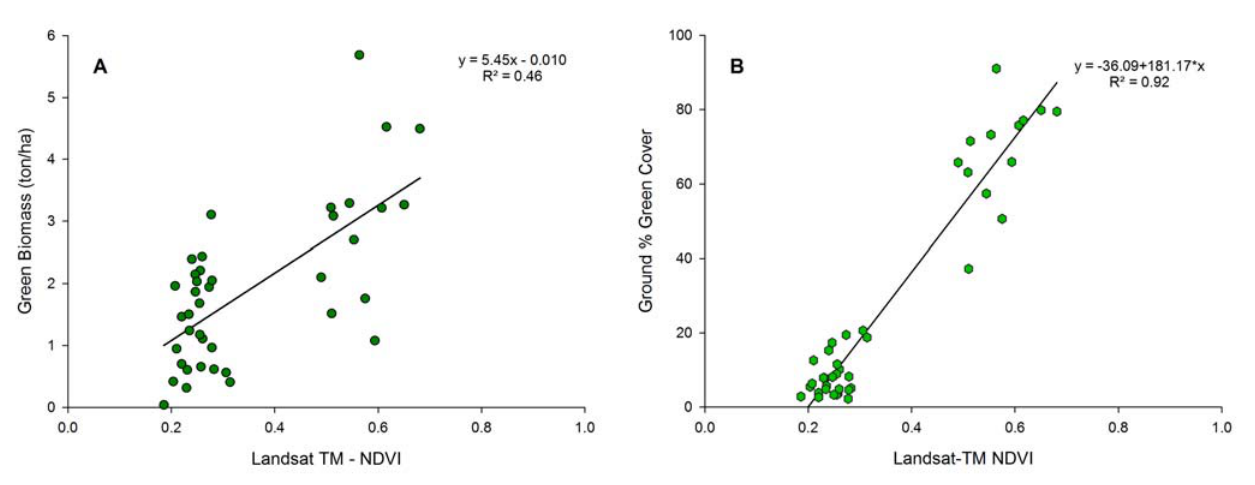
Figure 4. Regressed ground estimates of green biomass ( A ) and % green cover ( B ) relatively to Landsat TM NDVI